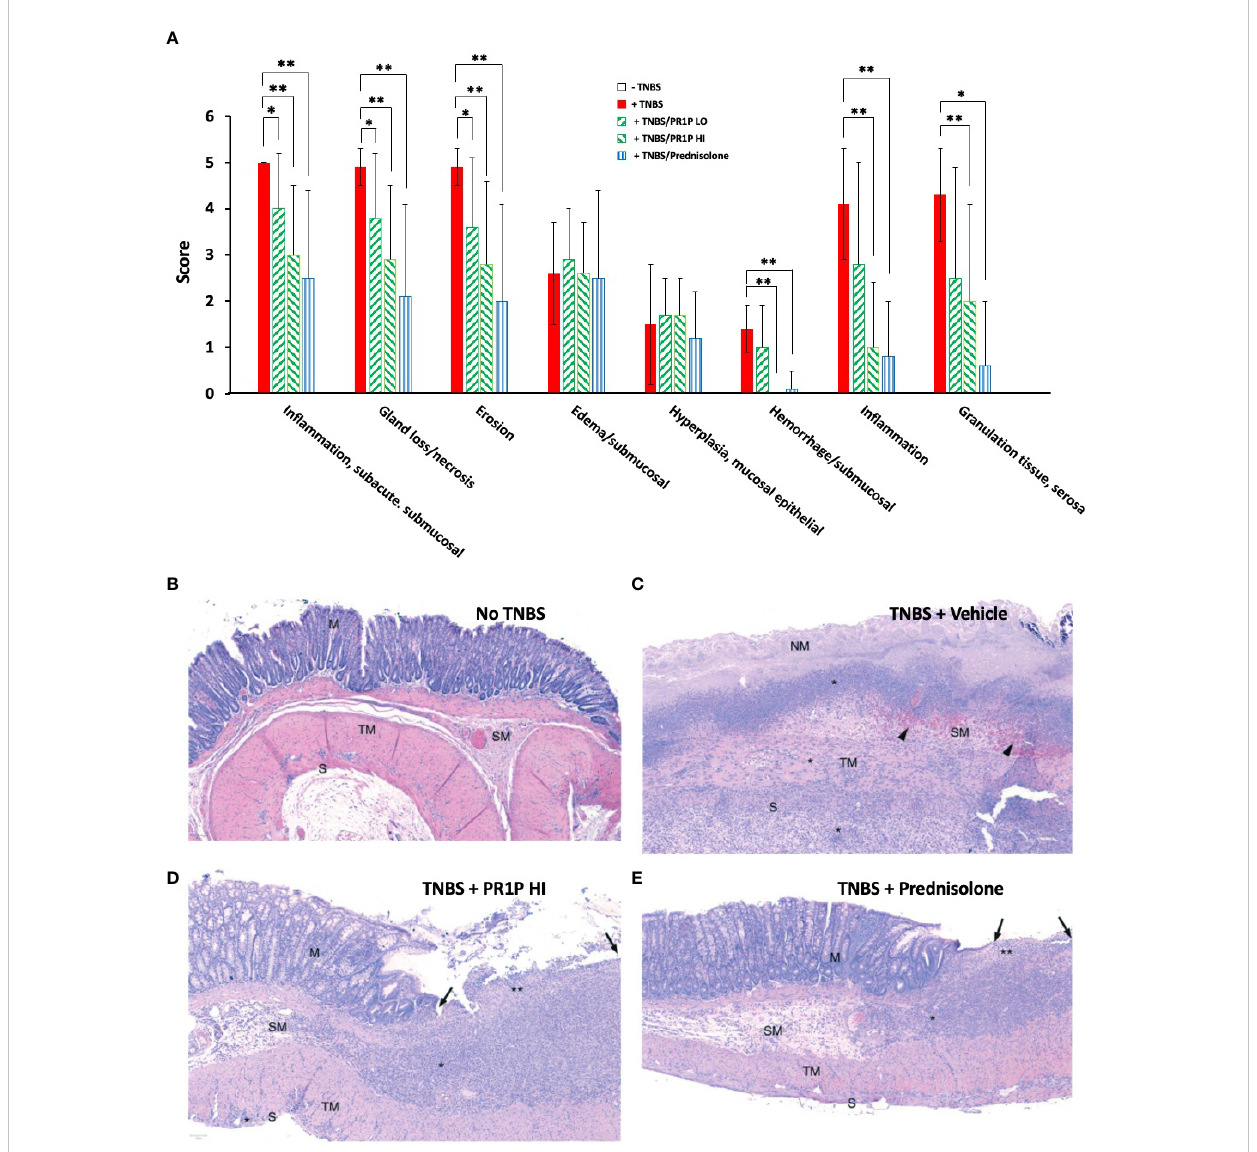
FIGURE 5 PR1P reduces disease and in fl ammation on histopathology in TNBS-induced colitis in rats. (A) Bar graphs showing Average Scores (Score) of indicated lesions from histology sections of the colon of rats 7 days after intra-rectal administration of TNBS (or carrier) and daily treatment of PR1P (0.5 or 5 mg/kg IP) or Prednisolone (10 mg/kg po) as indicated (See Methods), Data are mean + SEM. *p<0.04, **p<0.005. (n=8). (B-E) Representative images of H&E stained colon sections (100X) obtained from rats on day 7 following experiments described in (A) . (B) Representative image from Naïve animal. No histologic lesions observed in captured region. The mucosal glands (M) are within normal limits, as are the submucosa (SM), tunica muscularis externa (TM), and the serosa (S). (C) Representative image from animal with TNBS-induced colitis treated with vehicle (TNBS + Vehicle). No normal mucosa remains in captured region; all mucosa exhibits coagulative necrosis (NM: necrotic mucosa), with complete loss of the surface epithelium, consistent with erosion. A thick band of in fl ammatory cells (*) are visible at the mucosal-submucosal (SM) border. The submucosa is edema-expanded and contains abundant hemorrhage and erythrophagocytic macrophages (black arrowheads). In fl ammatory cells (*) also extend transmurally through the tunica musuclaris (TM) and serosa (S) into the serosal granulation tissue visible at the bottom of the image. (D) Representative image from animal with TNBS-induced colitis treated with high dose PR1P (5 mg/kg, TNBS + PR1P HI). The right side of the image exhibits in fl ammatory cell in fi ltration and gland loss (**) with surface epithelial loss (erosion; black arrows). The adjacent mucosa (M) is hyperplastic, with elongated colonic glands observed. The submucosa (SM) is expanded by edema and in fl ammatory cell in fi ltration (*). Very mild extension of in fl ammation (*) is seen through the tunica muscularis (TM) and into the serosa (S). (E) Representative image from animal with TNBS-induced colitis treated with Prednisolone (TNBS + Prednisolone). In fl ammatory cell in fi ltration with gland loss (**) and erosion (black arrows) are mild; the adjacent mucosa (M) exhibits reactive hyperplasia. There is expansion of the submucosa (SM) by edema (clear/pale pink area) and in fl ammatory cell in fi ltration (*). In fl ammatory cells are generally limited to the mucosal and submucosa with minimal involvement of the tunica muscularis externa (TM) and serosa